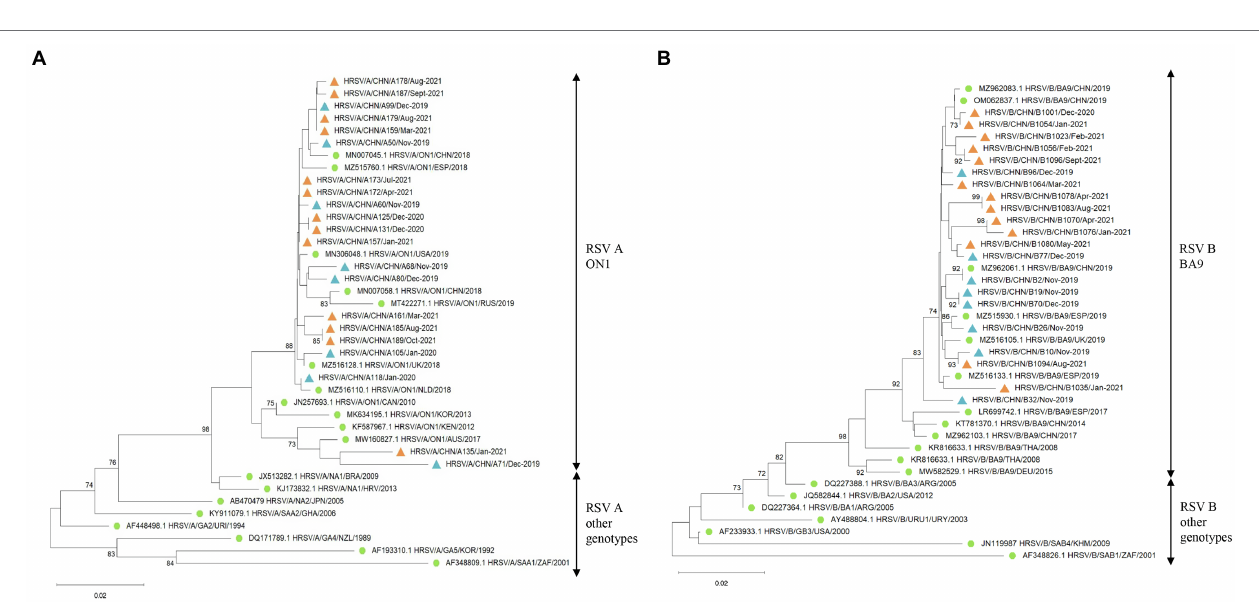
FIGURE 3 | The G gene phylogenetic trees of RSV A and B strains. The phylogenetic trees of RSV A strains (A) and RSV B strains (B) derived in the study during 2019–2021 based on the HVR2 of the G gene. The phylogenetic trees were constructed using neighbor-joining method with 1,000 bootstrap replicates. Bootstrap values > 70% were shown. Reference genotypes downloaded from the GenBank were labeled with green dots. RSV strains derived in the study were labeled with blue triangles before COVID-19 and orange triangles during the